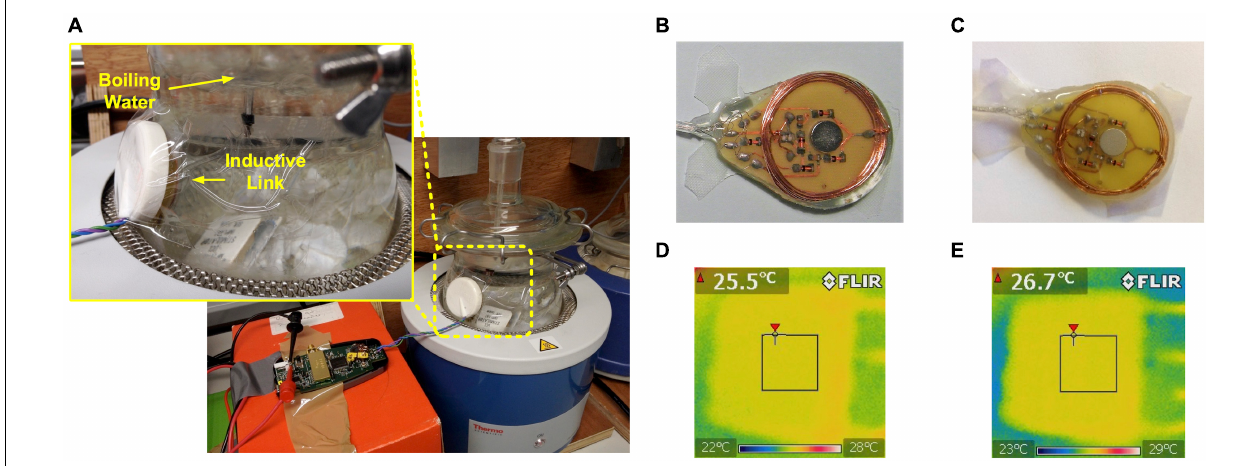
FIGURE 6 | Evaluation of feasibility for chronic implantation. (A) Setup of accelerated lifetime test; (B) Photo of the Rx coil PCB before the accelerated lifetime test; (C) Photo of the Rx coil PCB after accelerated lifetime test for 15 days; (D) Thermal image of the implant immediately after switched on at room temperature; (E) Thermal image of the implant 1 h after switched on in room